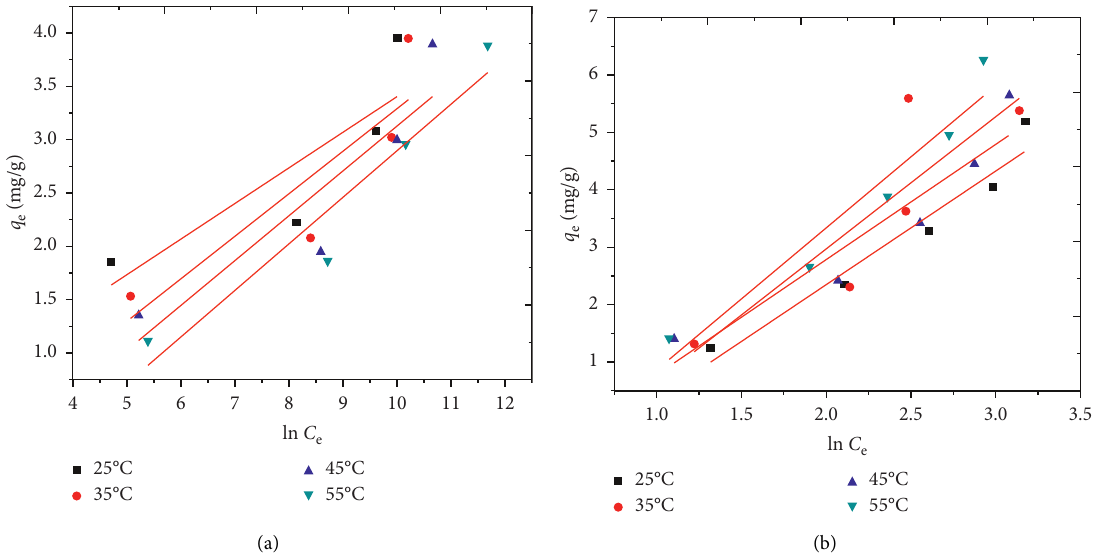
Figure 6: Temkin isotherm of (a) CR; (b) adsorption of SF at various